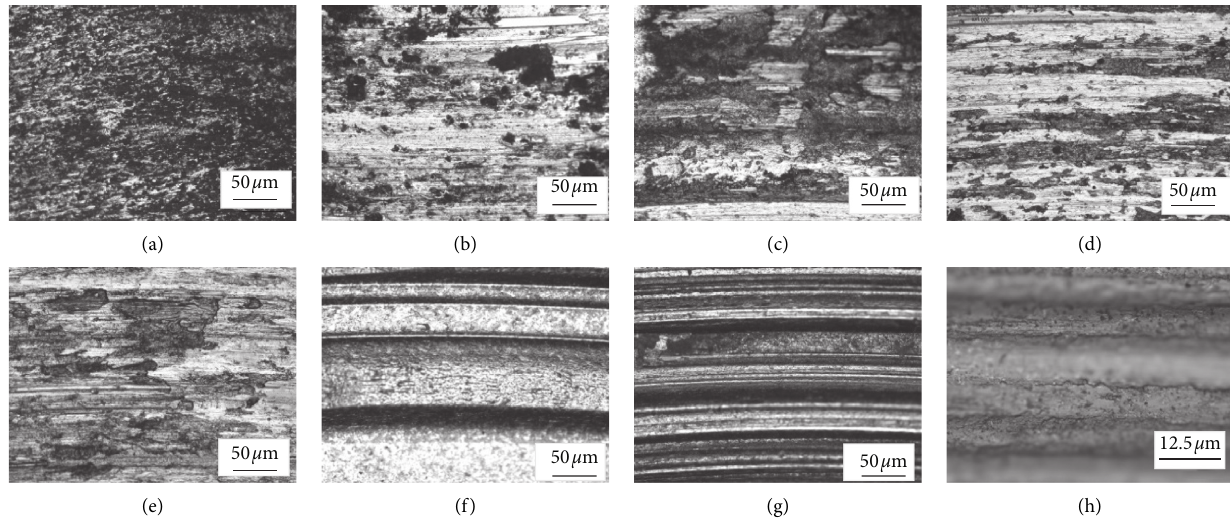
Figure 13: Worn morphologies of the S2 cladding at different temperatures: (a) room temperature; (b) 200 ° C; (c) 300 ° C; (d) 400 ° C; (e) 500 ° C; (f) 600 ° C; (g) 700 ° C; (h) 700 ° C with high